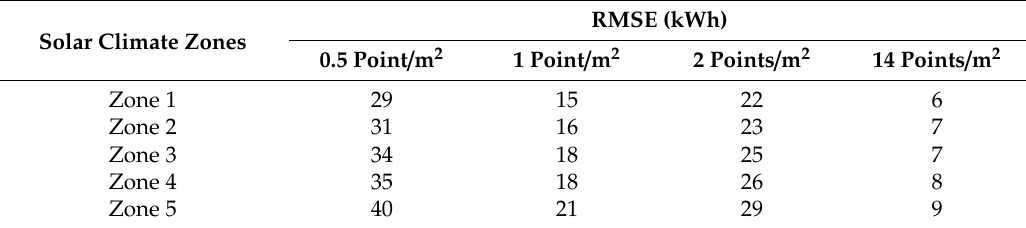
Table 13. Average daily electrical energy loss (kWh) due to the error in the estimation of the rooftop area for di ff erent point cloud densities: industrial buildings with a flat roof of 400 m 2 .